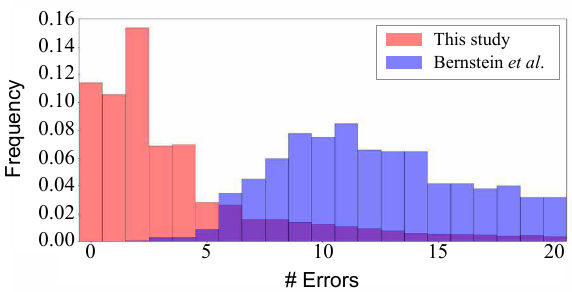
Figure 2: Histogram of number of errors in estimated S–M